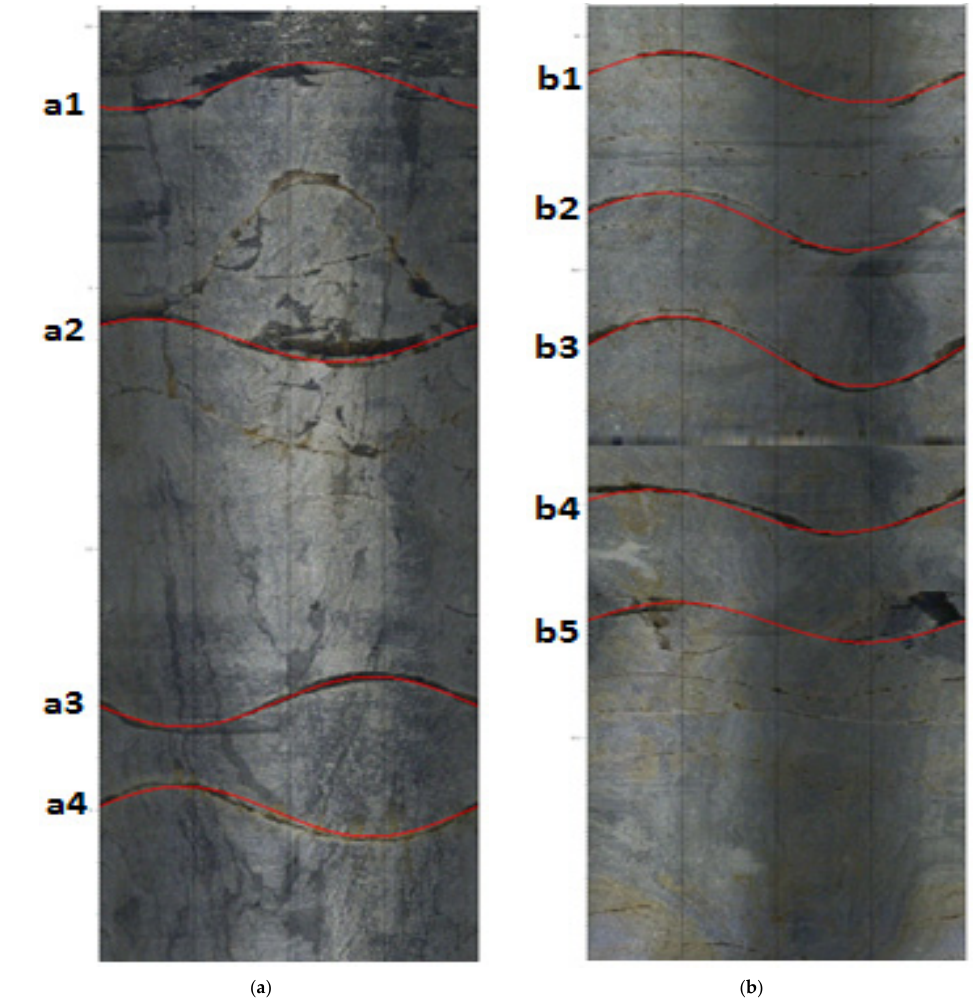
Figure 6. Sine function matching results of regions. ( a ) Results for Figure 3a; ( b ) Results for Figure 3b. When one or more sine curves with the largest number of specific weighted matching points are found in each divided area, a curve is selected as the optimal sine curve and used as the structural plane characteristic curve matched to the area. Finally, the depth position of the corresponding structural plane can be calculated according to the position of the optimal sinusoid. The dip direction of the structural plane can be calculated accord- ing to the phase angle of the optimal sinusoid. And the dip of the plane can be calculated